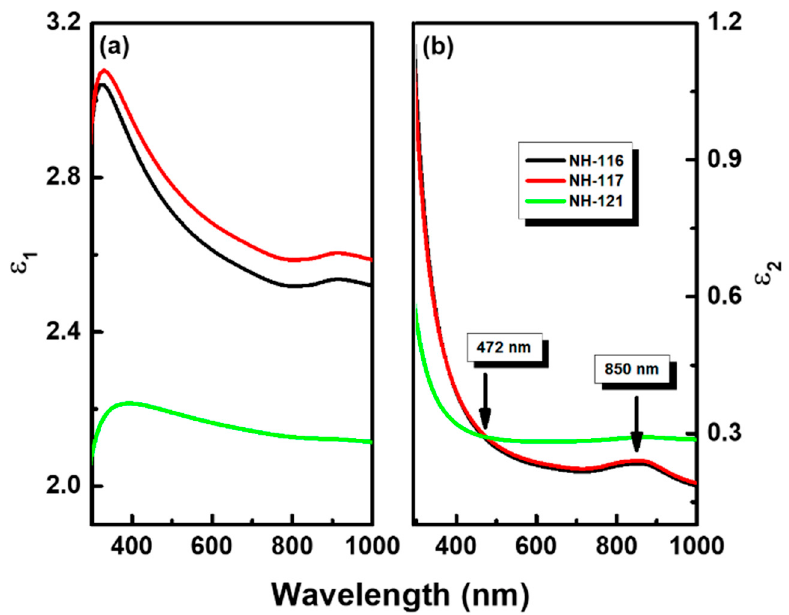
Figure 6. Spectral behavior of the ( a ) real ( ε 1 ) and ( b ) imaginary ( ε 2 ) parts of the complex dielectric constant ε of the films. The peaks in the imaginary part of the spectrum at 850 nm are related to the interband transition in Al.